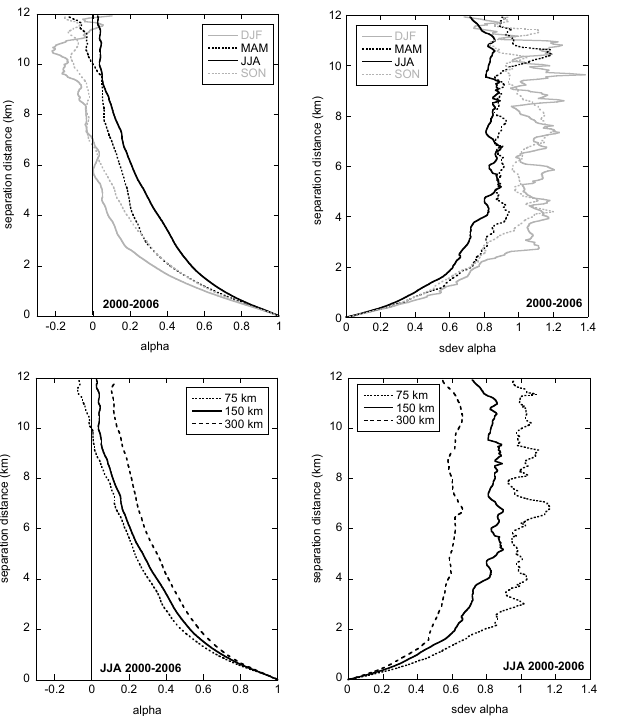
Fig. 1. Profiles of seasonal ensemble means (left panels) and stan- dard deviations (right panels) of the overlap parameter alpha as a function of layer separation distance calculated from the 7-year MI- CROBASE dataset. Top panels are for the 150km segment size and all four seasons: December-January-February (DJF, winter), March-April-May (MAM, spring), June-July-August (JJA, sum- mer), September-October-November (SON, fall). Bottom panels are for different segment sizes for JJA.